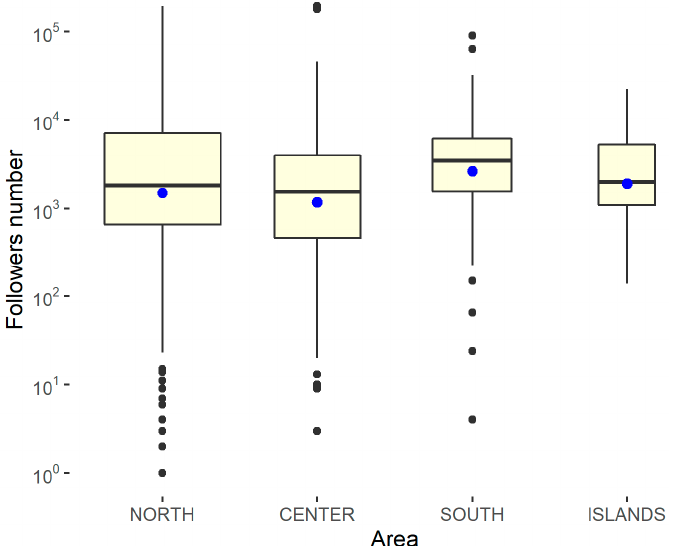
Figure 7. Kruskal–Wallis rank-sum test in the number of followers for the area. Kruskal–Wallis chi- squared = 8.5252, df = 3, p -value = 0.03632 (there is a significant difference). The p -value indicates that there was a significant difference with respect to the geo- graphical area; however, it was necessary to analyze all of the possible pairs and to con- sider an adjusted p-value, as reported in Table 6, from which it can be deduced that there was a significant difference in only the central–south region.